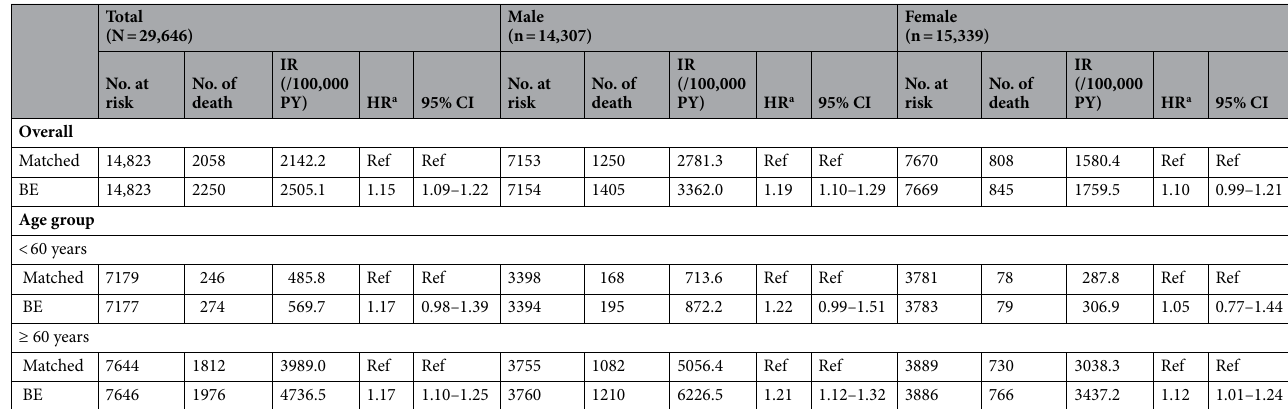
Table 2. Mortality in the bronchiectasis cohort relative to the matched cohort. Data are presented as risk ratios (95% confidence interval). a Unadjusted hazard ratio. BE, bronchiectasis; IR, incidence rate; PY, person- years; HR, hazard ratio; CI, confidence interval; Ref,